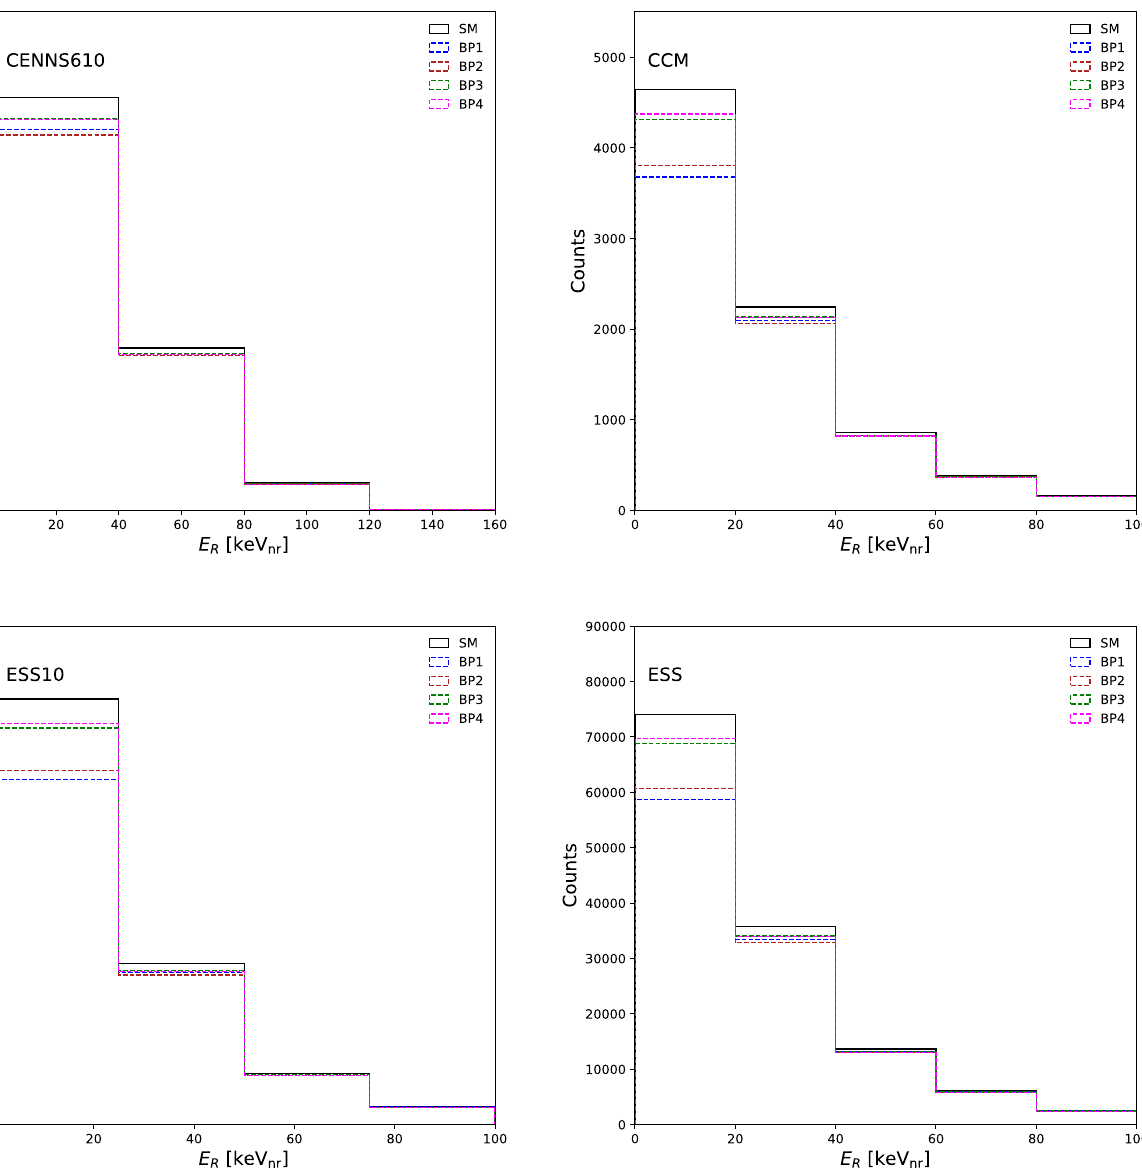
Fig. 6 Expected CE ν NS rate for each of the experimental configu- rations of Table 2, assuming 1 year of operation. The SM prediction is shown as a solid black line, and dashed lines represent the differ- ent benchmark points of Table 1. For CCM, ESS10 and ESS we have